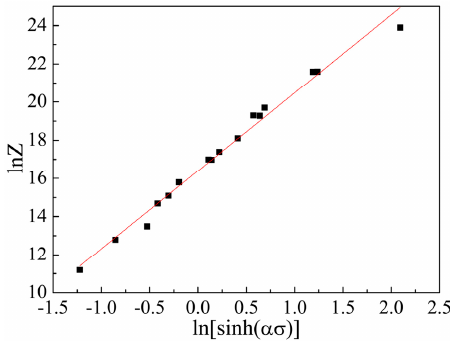
Figure 4. Determination of material constant A based on the relationship between ln Z and ln [ sinh ( ασ )]